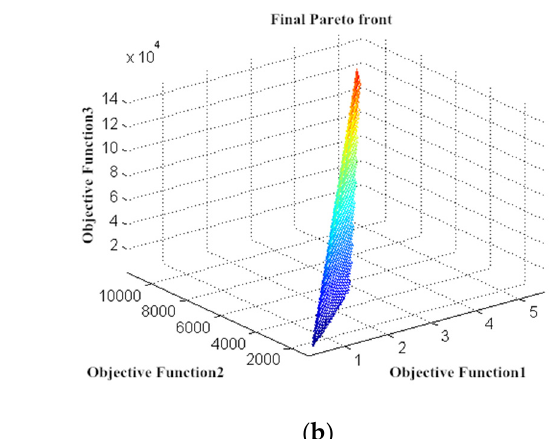
Figure 8. Convergence characteristics.